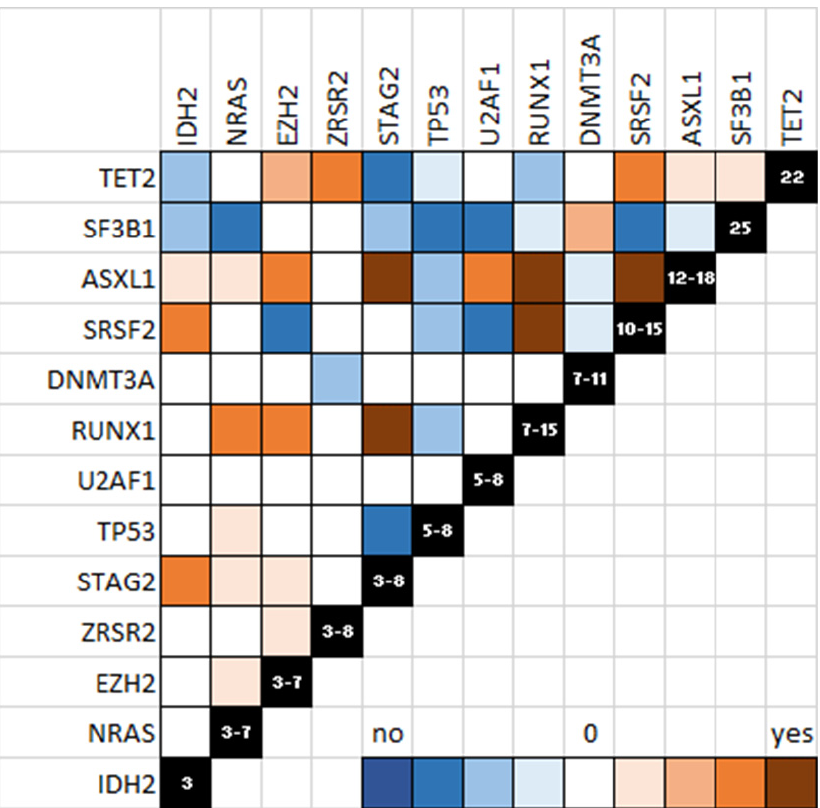
Figure 2. Schematic representation of mutations in MDS. Co-occurring mutations are shown in brown and mutually exclusive mutations are shown in blue. The power of linkage or exclusion is indicated by the color gradient.